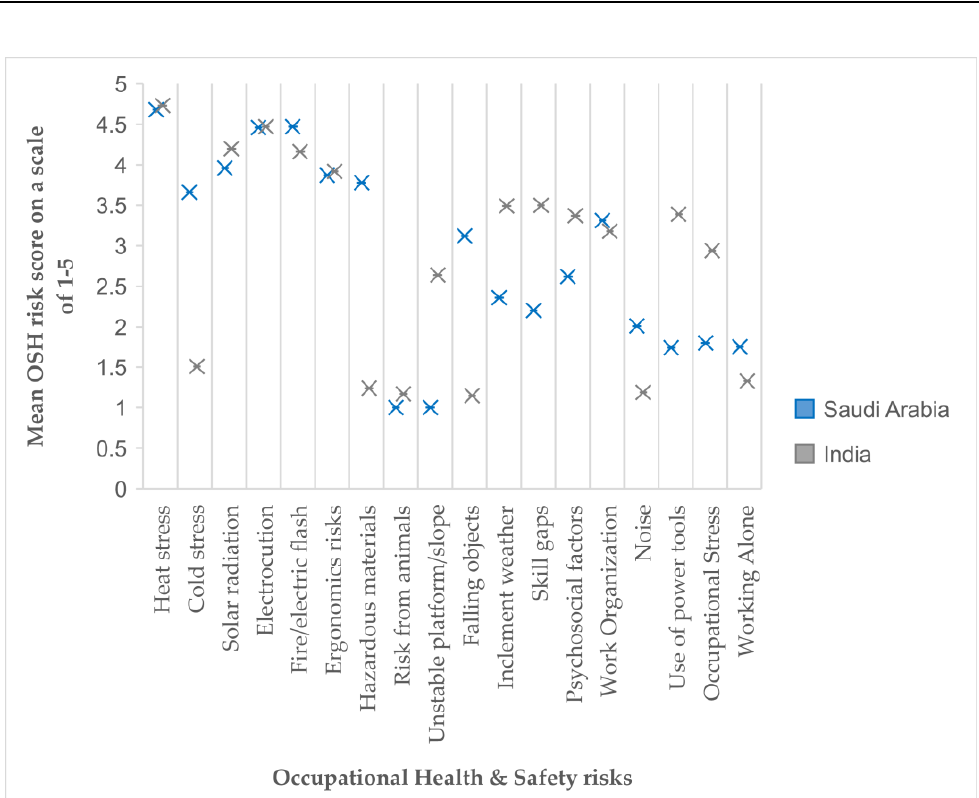
Figure 4. Mean scores for OSH risks for solar PV workers engaged in Saudi Arabia and India. The higher the score, the higher the perceived risk.